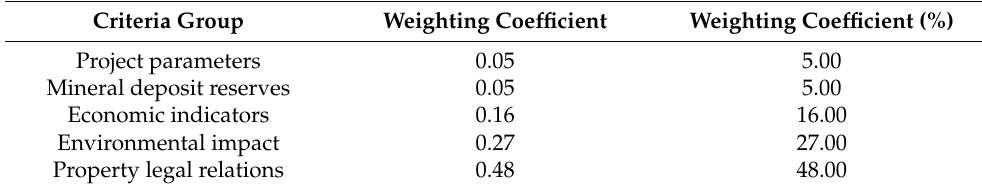
Table 5. Weighting coefficients for the main group of